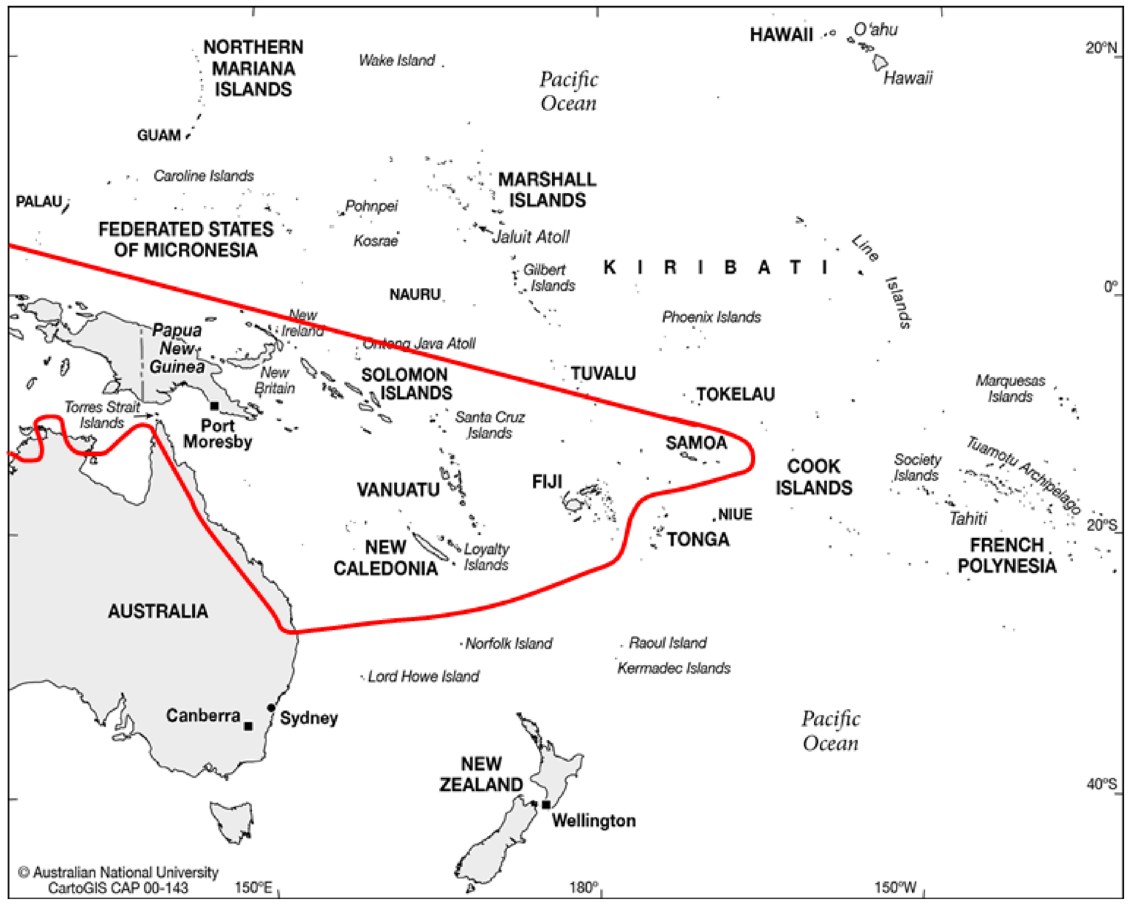
Fig. 12. Regional distribution of the genus Huberantha (Annonaceae) in the Pacific. Base map sourced from CartoGIS, College of Asia and the Pacific, The Australian National University,